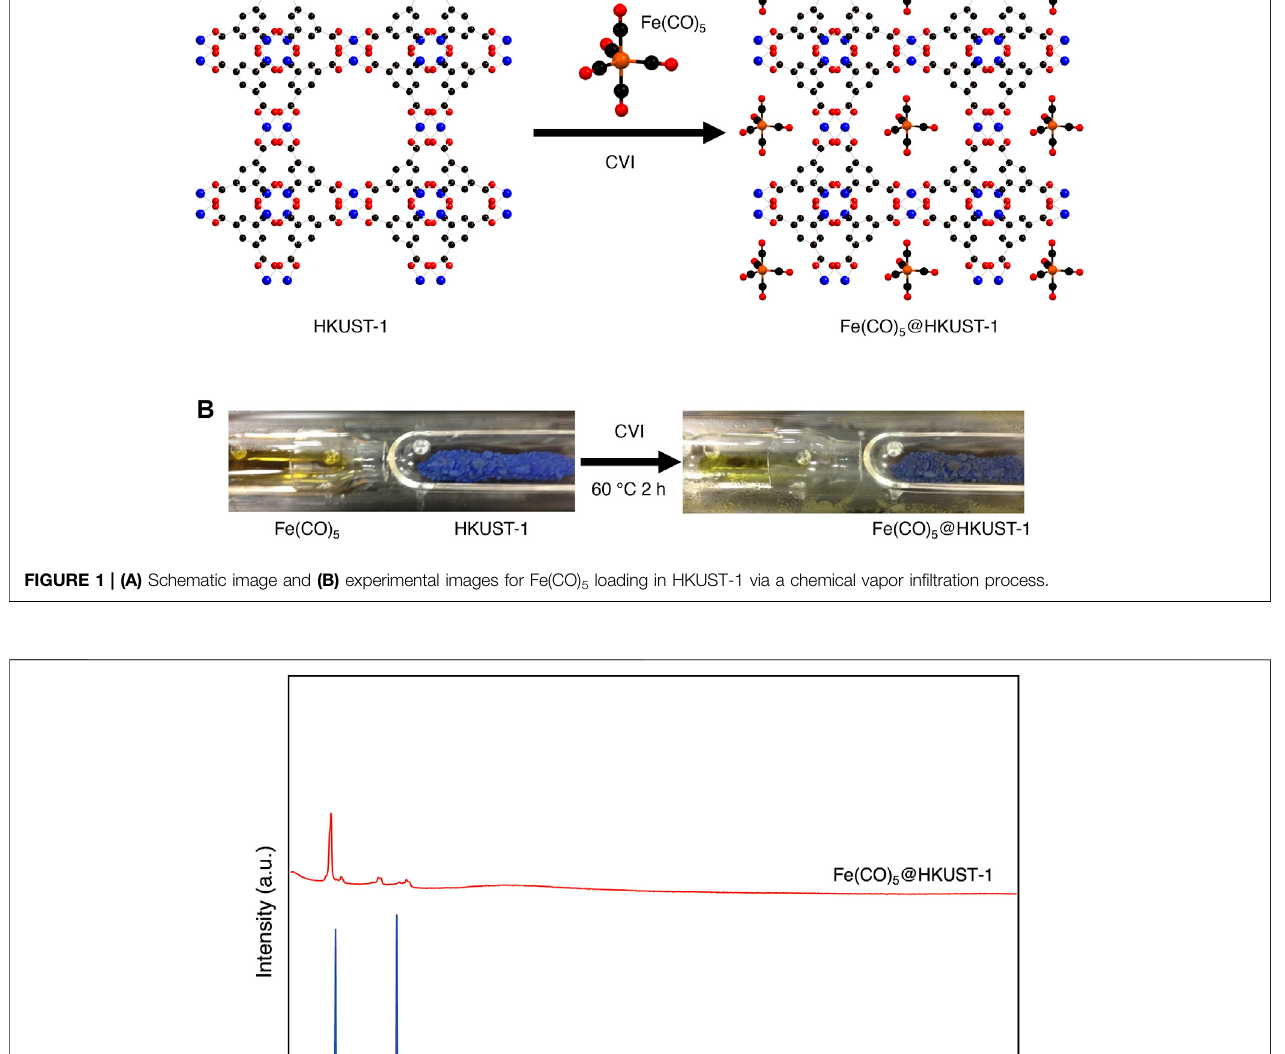
Frontiers in Chemistry |